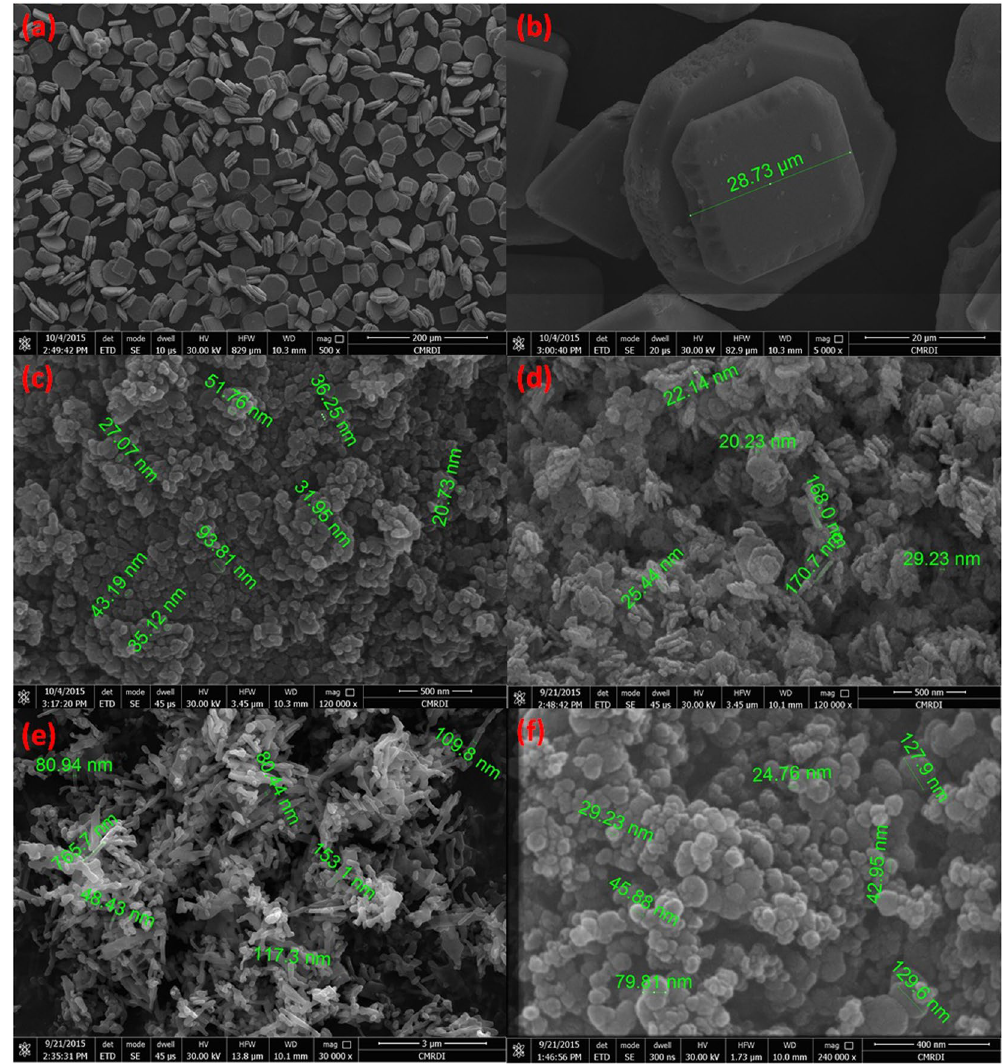
Figure 23. FESEM images of SnO nanoparticles after reaction with POM ( a and b ), Fe 2 O 3 nanoparticles after reaction with POM ( c ), CuO nanoparticles after reaction with POM ( d ), Co 3 O 4 nanorods after reaction with POM ( e ), and cross-linked carbon nanoparticles ( f